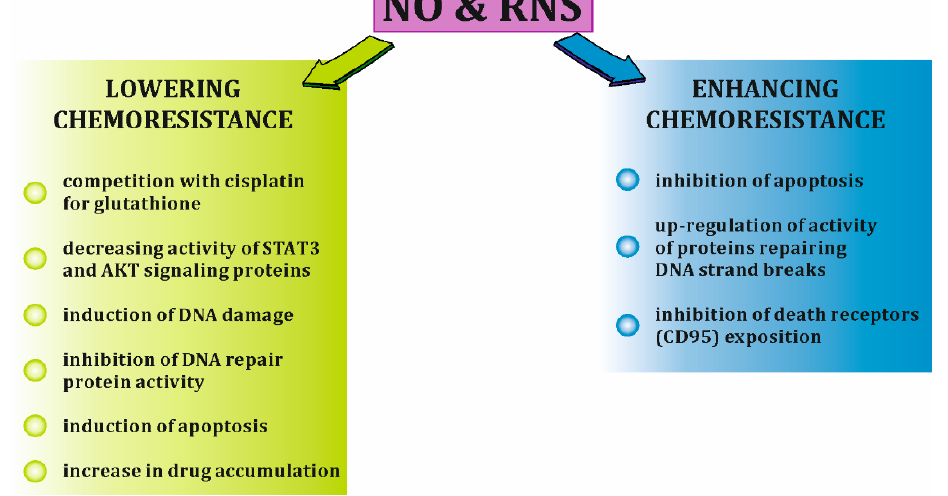
Figure 4. Selected mechanisms of NO / RNS impact on cisplatin resistance in cancer cells. RNS , reactive nitrogen species; STAT3 , signal transducer and activator or transcription pathways 3; AKT, serine-threonine protein kinase.